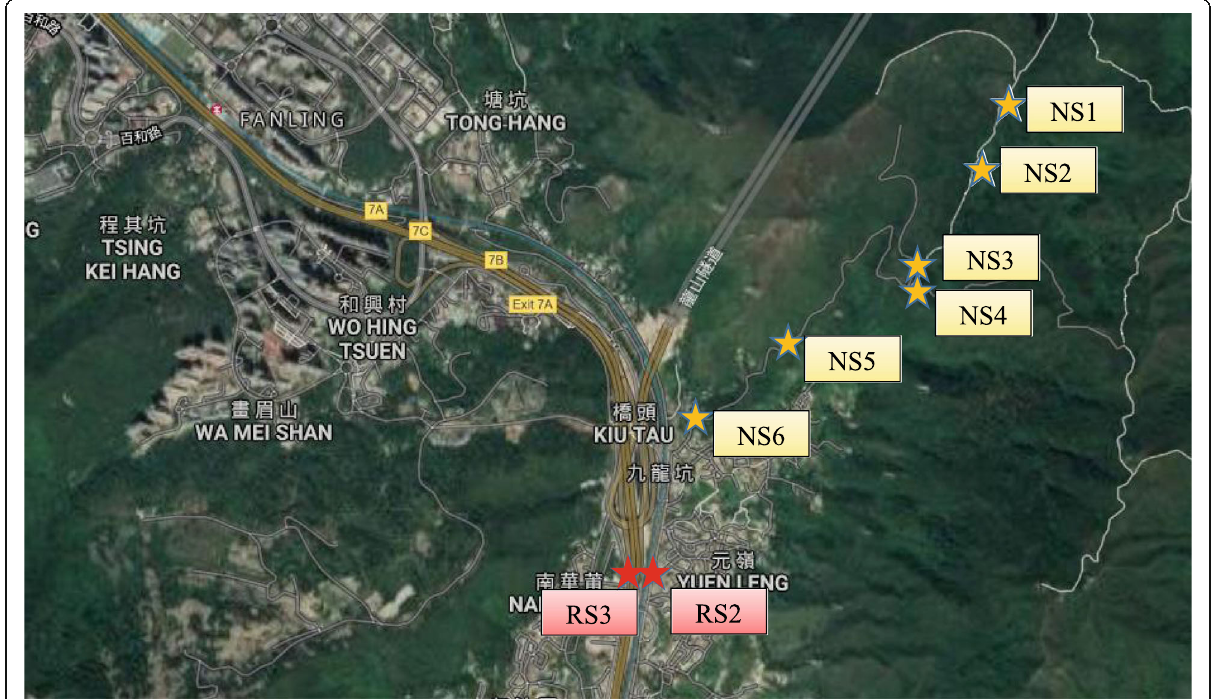
Fig. 3 Locations of field air parameter